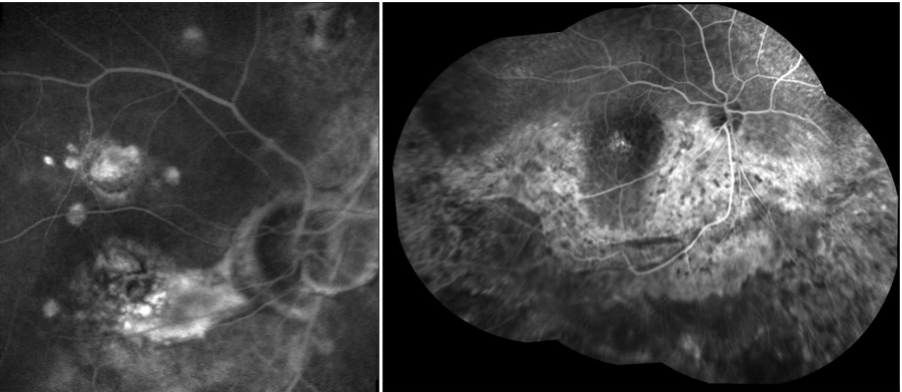
Figure 8. Late phase of FA showing granulomas and CME.